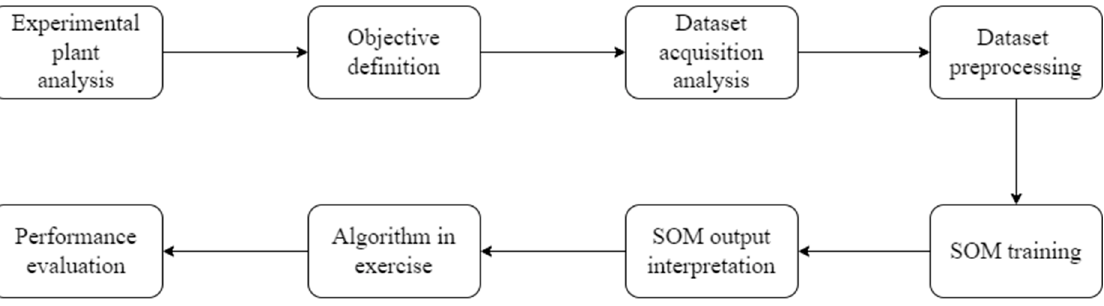
Figure 2. The research